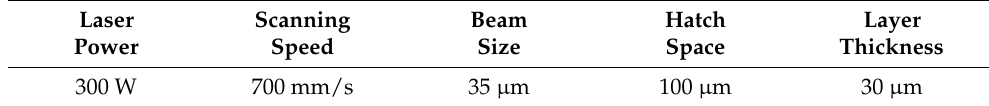
Table 1. Parameters of the SLM process.